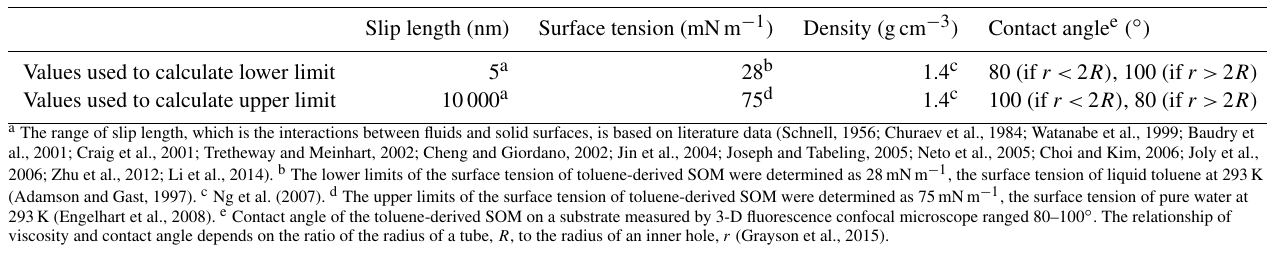
Table 2. Physical parameters used to simulate material flow in the poke-flow experiments. R and r indicate the radius of a tube and the radius of an inner hole, respectively.